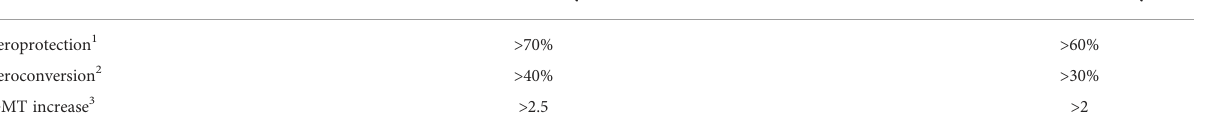
TABLE 1 CHMP criteria for the evaluation of in fl uenza